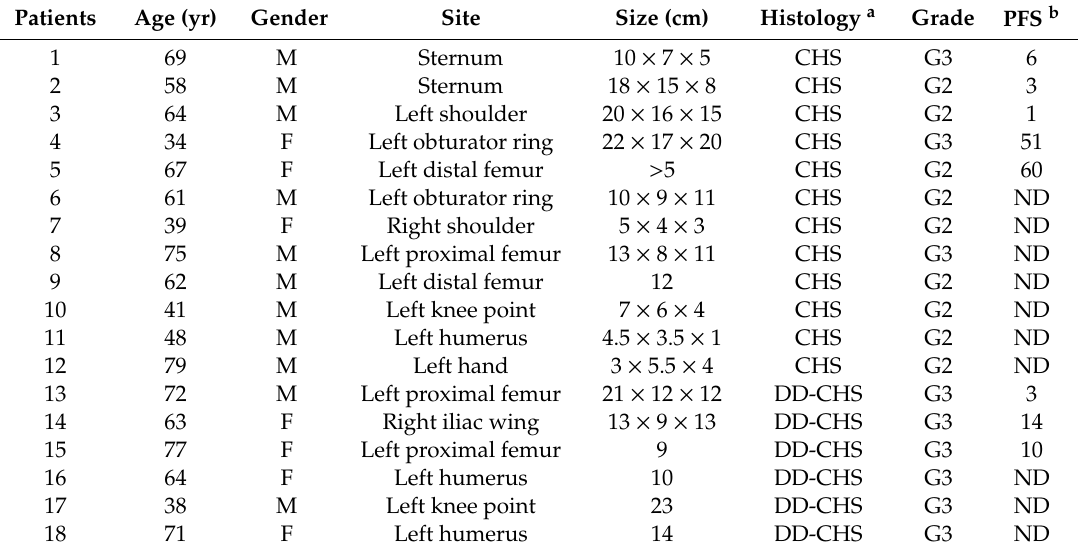
Table 1. Clinicopathological and Histopathological findings of enrolled chondrosarcoma patients.